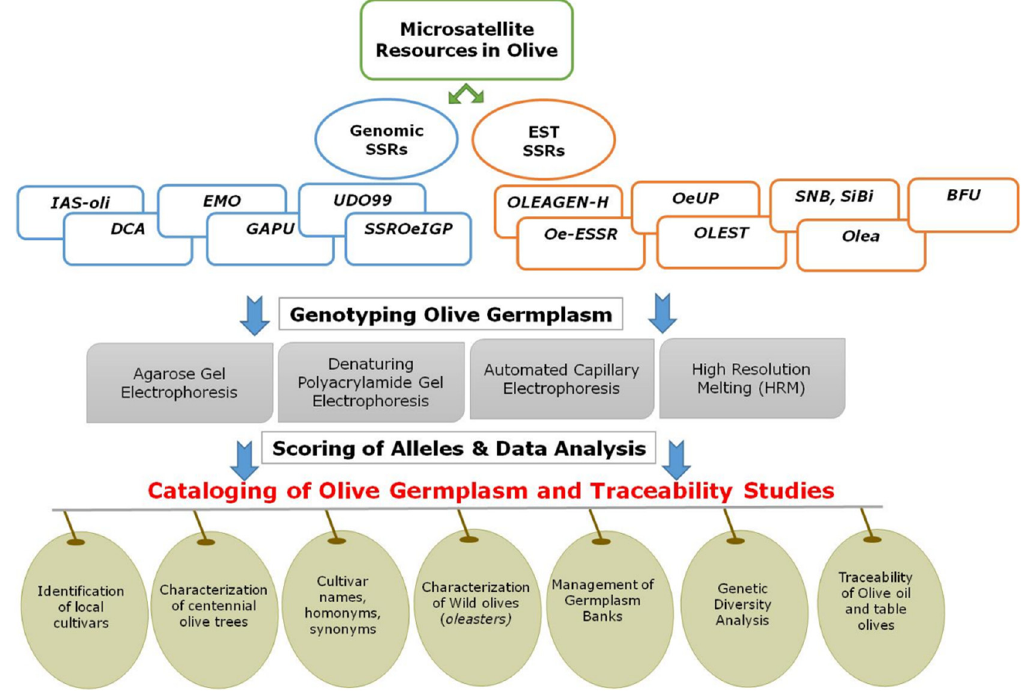
Figure 1. Microsatellite resources and applications in olive germplasm cataloging, authenticity and traceability.